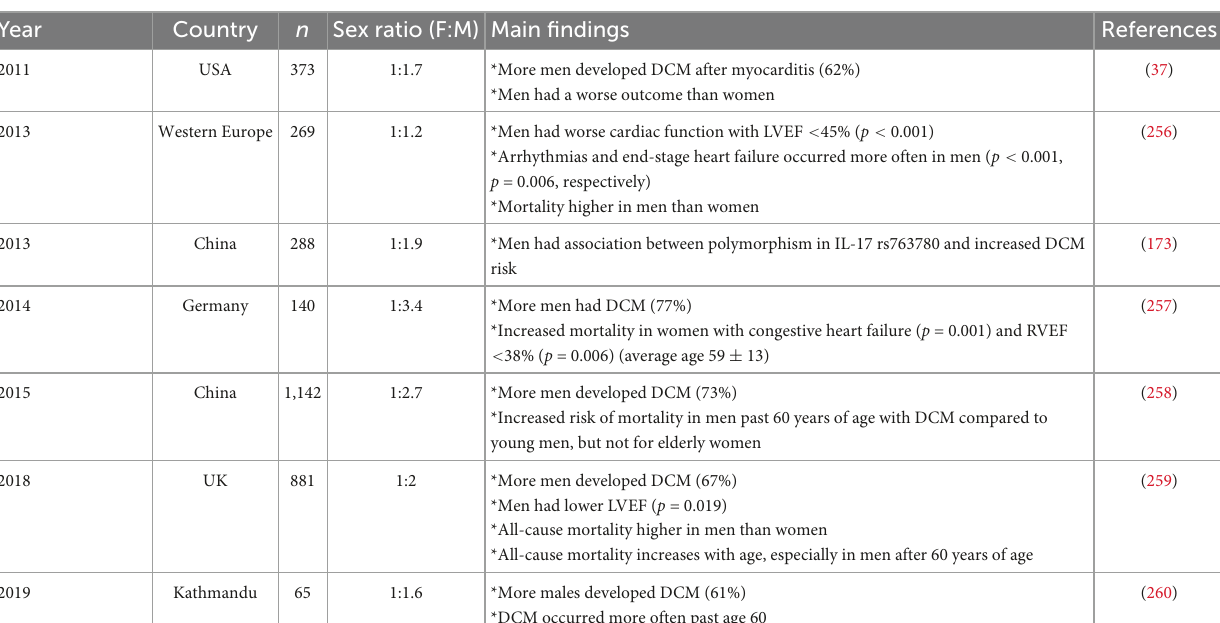
TABLE 2 Studies of sex differences in DCM in the past